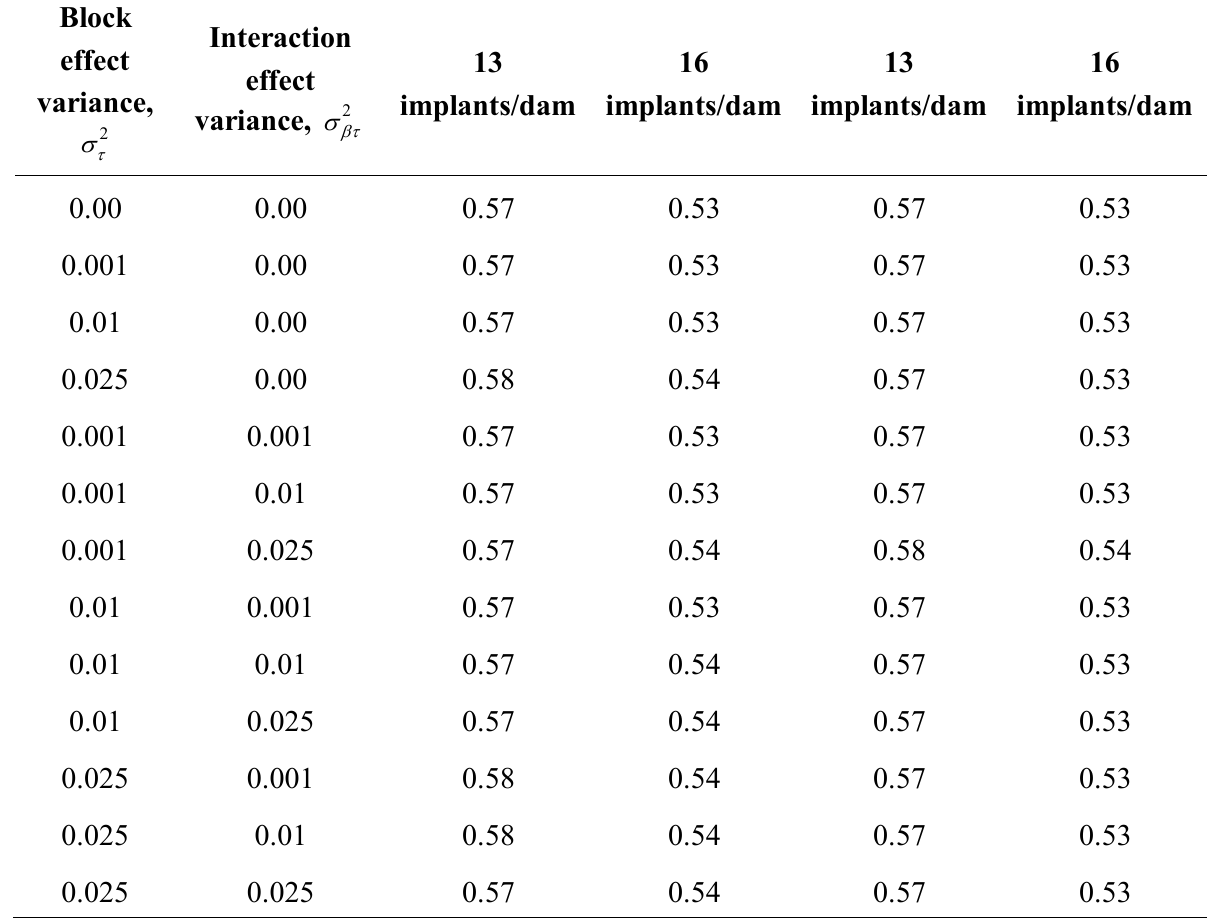
Table 3. Power to detect a 7.1 percentage point difference in prenatal loss using a linear model: Two-block